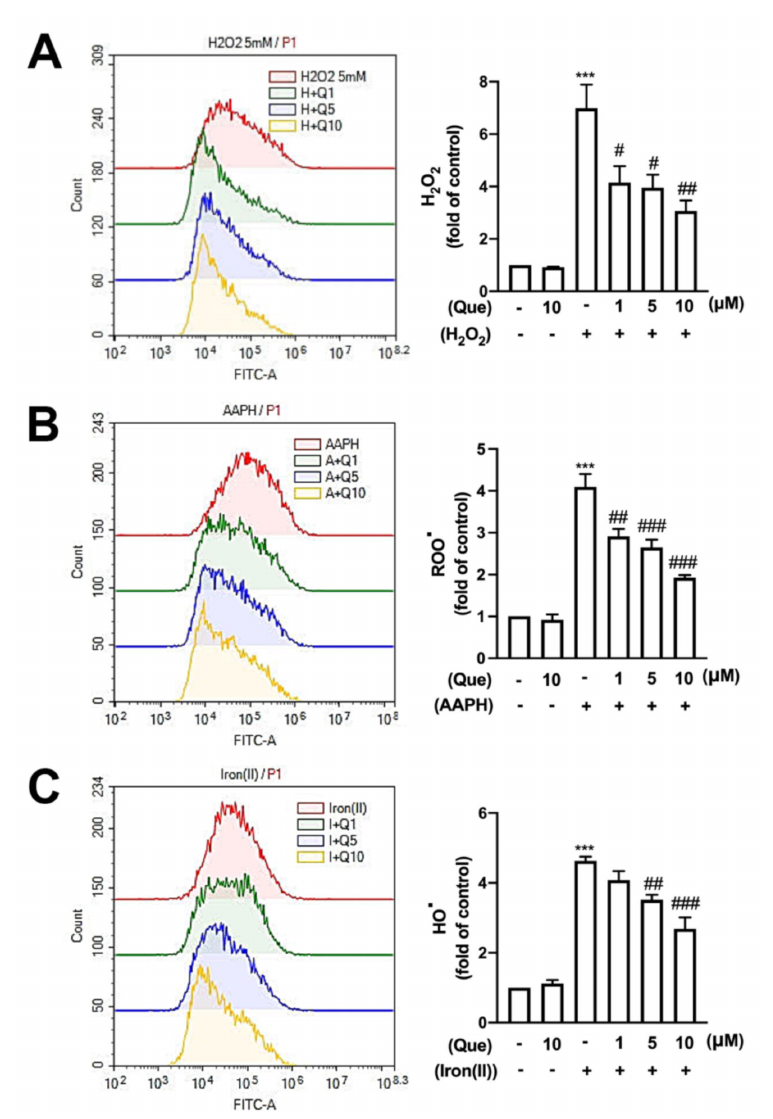
Figure 6. Effects of quercetin on reactive oxygen species (ROS) production in microglial cells. IMG cells were stimulated with various concentrations of quercetin (1, 5, or 10 µ M) for 30 min followed by stimulation with 5 mM hydrogen peroxide (H 2 O 2 ) ( A ), 5 mM 2, 2 (cid:48) -azobis (2-amidinopropane) hydrochloride (AAPH) ( B ), or 1 mM iron(II) plus 0.5 mM H 2 O 2 ( C ) for another 90 min. Following incubation with 10 µ M 2 (cid:48) , 7 (cid:48) -dichlorodihydrofluorescein diacetate (DCFH-DA) for 40 min, dichlo- rofluorescein (DCF) fluorescence intensity was detected by flow cytometry. Each bar represents the mean ± SEM ( n = 4). *** p < 0.005 compared with the control group. Note: ### p < 0.005, ## p < 0.01, # p < 0.05 compared with the stimulated group